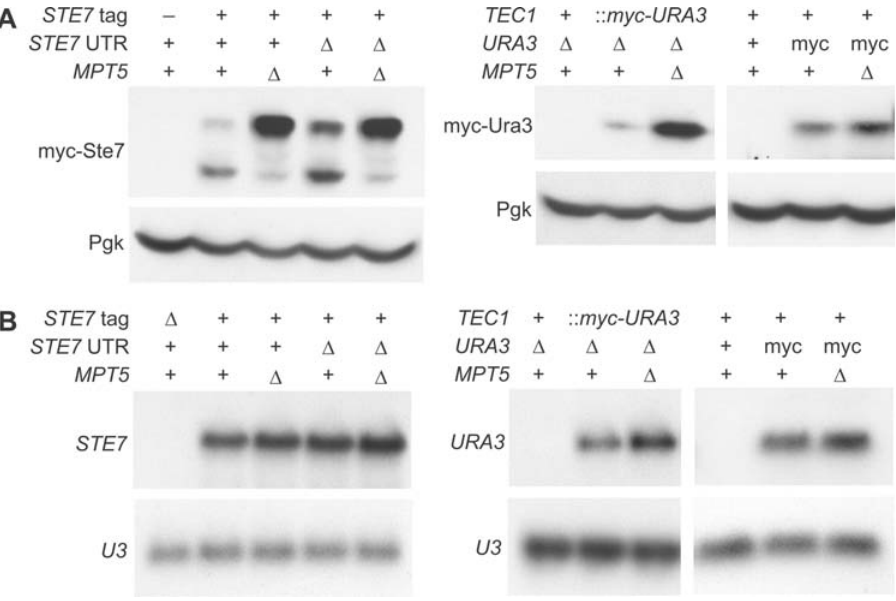
Figure 4. UTR sequences and repression by MPT5 . Yeast strains were grown under yeast-form conditions. Protein and RNA extracts were prepared and analyzed by (A) western blot and (B) northern blot. Pgk protein and U3 RNA served as loading